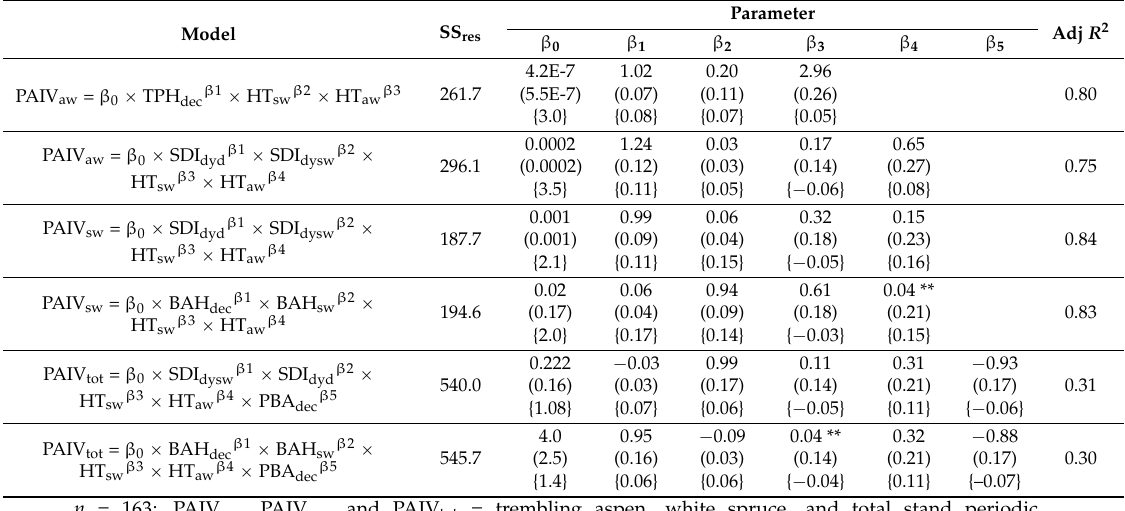
Table 2. Fit statistics and parameter estimates for the best and second best models for trembling aspen, white spruce, and total stand periodic annual increment in volume (PAIV aw , PAIV sw , and PAIV tot ,